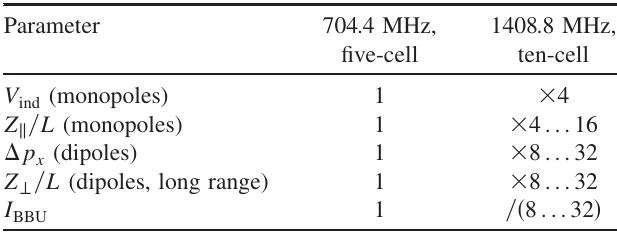
TABLE XIV. HOM parameter scaling for linear frequency scaling and doubling of accelerating cells, which means perfect cells in the worst case, assuming ‘‘additive’’ ( R=Q ). Parameter 704.4